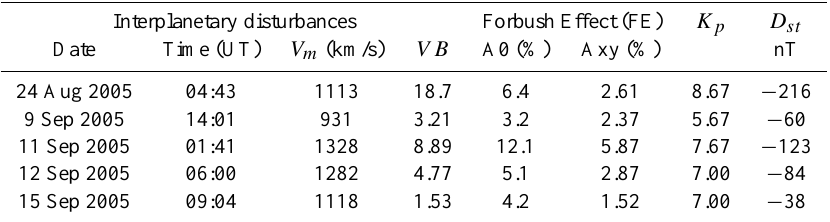
Table 2. Significant interplanetary disturbances, related Forbush effects and geomagnetic activity indices recorded during August–September 2005. Parameters include: Date: date of SSC; Time: SSC arrival time at Earth; V m : mean velocity of the disturbance propagation from Sun to the Earth; V B : product maximum SW velocity Vmax and IMF intensity B max in the considered disturbance; A0: maximum value of CR density variation during the FE (the magnitude of FD) beyond the magnetosphere, Axy: maximum equatorial component of the CR anisotropy during the FE by GSM method derived; K p & D st : maximum values of geomagnetic activity indices. Interplanetary disturbances Forbush Effect (FE) K p D st